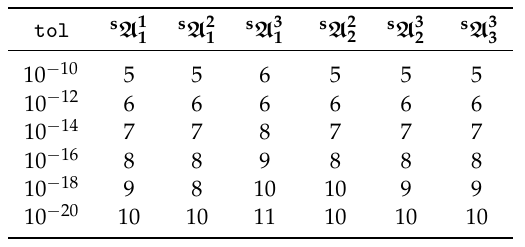
1/2 L ] (ratios of polynomials in 1/ η ) −